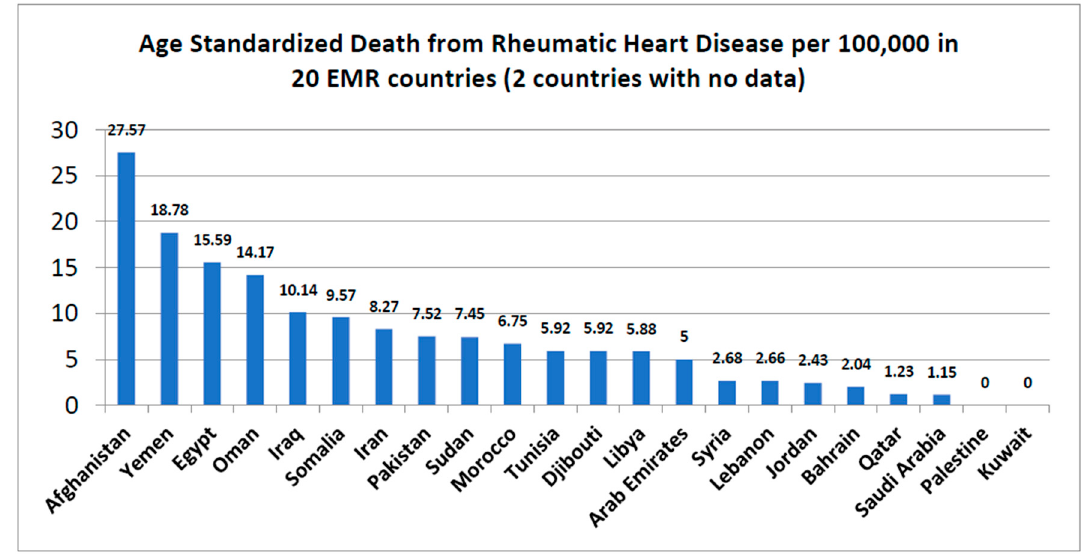
Figure 5. Age standardized deaths per 100,000 from Rheumatic Heart Disease for the 20 countries of the Eastern Mediterranean region. Source: ( www.worldlifeexpectancy.com ) Data source: published by WHO, 2014.